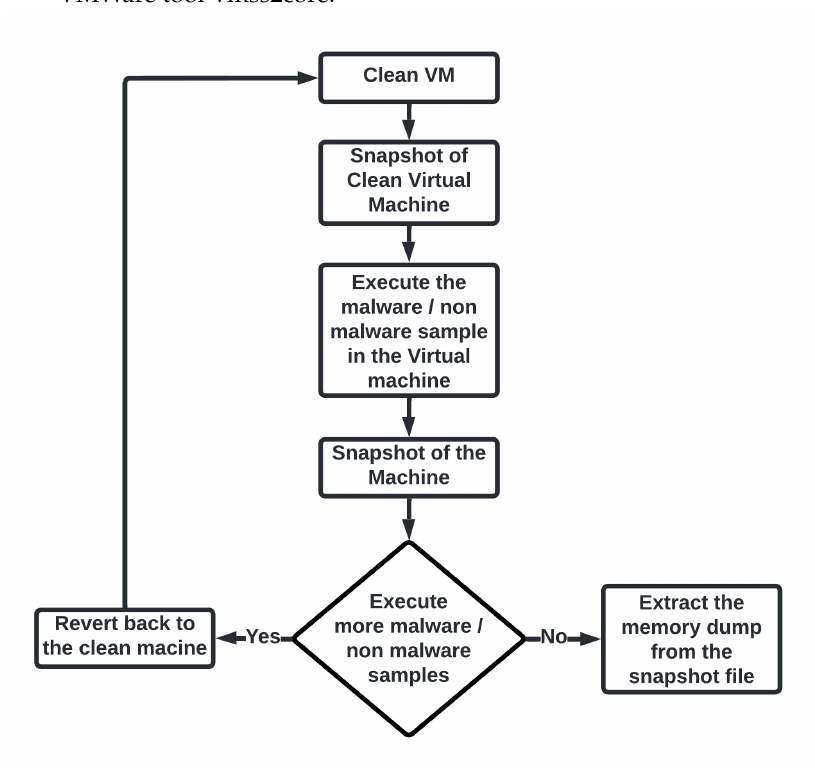
Figure 8. The flow of the snapshot collection